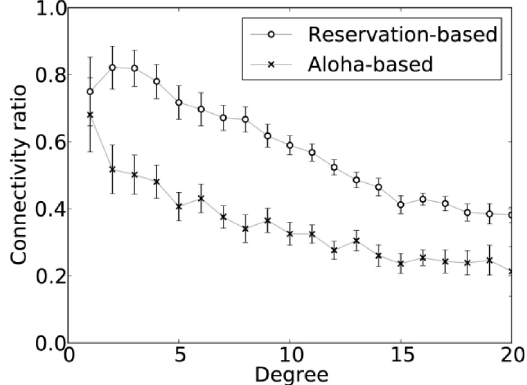
Figure 4. Mean connectivity ratio by degree for unidirectional links in simulated environment.